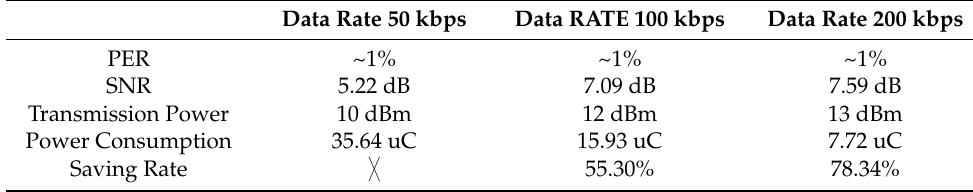
Figure 5. Relationship between PER and SNR in different data rates. Table 5. Comparison table in different parameters.